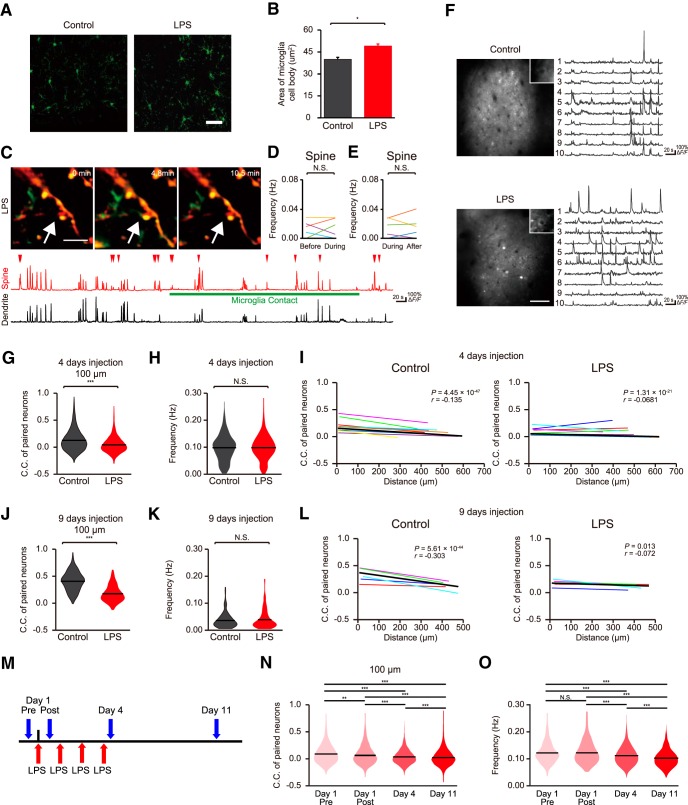
Microglia-synapse interactions in mice following LPS injections. A, B, Intraperitoneal injection of LPS activated microglia, as verified by morphologic appearance (A), which included a significant increase in soma diameter (B). Soma area increased from 40.1 ± 9.2 μm2 in saline-injected mice (n = 58 cells from three mice) to 49.2 ± 11 μm2 in LPS-injected mice (n = 80 cells from three mice, p = 4.30 × 10−7, unpaired t test). C, top, Fluorescent image of a dendrite in L2/3 of the primary motor cortex of an LPS-injected mice showing the simultaneous imaging of spines (tdTomato; red) and microglia (EGFP; green). Scale bar: 5 μm. As in Figure 1, the lower trace shows a sample recording of Ca2+ transients (GCaMP6f fluorescence ΔF/F) in a single spine (upper) and in the parent dendrite (lower) before, during, and after microglial contact. Local synaptic activity was not effected by microglial contact. The white arrow indicate the spine contacted by microglia process. D, E, The frequency of Ca2+ transients in spines during the period of microglial contact was not significantly different from that either before (D) or after (E) contact. Each line shows data from a single experiment [D: 0.013 ± 0.003 Hz (during) vs 0.012 ± 0.003 Hz (before), p = 0.816, n = 6 fields from three mice; E: 0.013 ± 0.004 Hz (during) vs 0.014 ± 0.005 Hz (after), p = 0.843, n = 6 fields from three mice, paired t test]. F, Typical fields of view of neurons with GCaMP6f fluorescence in L2/3 of the primary motor cortex of saline-injected mice (upper) and LPS-injected mice (lower), with accompanying representative ΔF/F Ca2+ traces from ten individual neurons in each mouse. G–L, Distribution of C.C.s (G, J) and of neuronal firing frequencies (H, K) in mice injected with either saline or LPS for 4 d (G, H) or 9 d (J, K). LPS injections decreased the C.C. for pairs of closely located neurons but had no effect on neuronal firing frequencies. Panels I, L show the relationship between C.C. and neuronal separation for mice injected with either saline or LPS for 4 d (I) or 9 d (L). Each line shows the slope of the correlation from individual mice, while the values in the top right corner show the slope of the fits to the complete data set (and the value of the Pearson’s correlation test), the fit to this grouped data are shown as the solid dark line. Averaging the individual fits gives a mean slope correlation of: r = –0.149 ± 0.019 for 4 d saline mice (p = 5.43 × 10−5, one-sample t test, n = 9 mice), r = –0.008 ± 0.039 for 4 d LPS mice (p = 0.850, n = 9 mice), r = –0.285 ± 0.065, for 9 d saline (p = 0.012, n = 5 mice), and r = –0.107 ± 0.048 for 9 d LPS [p = 0.091, n = 5 mice; G: saline-injected mice (4 d injection, n = 9 mice); 0.12 ± 0.004, LPS-injected mice (4 d injection, n = 9 mice); 0.043 ± 0.002, p = 7.02 × 10−72, Wilcoxon rank sum test; H: control (4 d injection, n = 464 neurons from nine mice); 0.098 ± 0.002 Hz, LPS (4 d injection, n = 568 neurons from nine mice); 0.098 ± 0.002 Hz, p = 0.841, Wilcoxon rank sum test; I; control (4 d injection); r = –0.135, p = 4.45 × 10−47, LPS (4 d injection); r = –0.0681, p = 1.31 × 10−21, Pearson’s correlation test; J; saline-injected mice (9 d injection, n = 5 mice); 0.34 ± 0.008, LPS-injected mice (9 d injection, n = 5 mice); 0.18 ± 0.009, p = 3.61 × 10−30, Wilcoxon rank sum test; K; saline-injected mice (9 d injection, n = 141 neurons from five mice); 0.033 ± 0.002 Hz, LPS-injected mice (9 d injection, n = 108 neurons from five mice); 0.037 ± 0.003 Hz, p = 0.60, Wilcoxon rank sum test; L; control (9 d injection); r = –0.303, p = 5.61 × 10−44, LPS (9 d injection); r = –0.072, p = 0.013, Pearson’s correlation test]. Hence LPS injection abolished the correlation between C.C. and neuronal separation. M–O, In an additional cohort of mice, L2/3 neurons were imaged before LPS< and again 1 and 4 d after daily LPS injections, and then after 7 d of recovery from the last LPS injection (M). The distributions of the C.C. (N) and the neuronal firing frequencies (O) over these time periods are shown. LPS injection caused a significant decrease in C.C., which was evident by the first day of injection and did not recover following a week after the last LPS injection. (N). From 4 d after LPS, the firing frequency in this mouse cohort decreased, and there was a further decrease by one week after the last LPS injection [O; N: F(3,19984) = 189.29, p = 0.002 (day 1 pre; 0.089 ± 0.004 vs day 1 post; 0.074 ± 0.003), p = 3.77 × 10−9 (day 1 pre; 0.089 ± 0.004 vs day 4; 0.035 ± 0.002), p = 3.77 × 10−9 (day 1 pre; 0.089 ± 0.004 vs day 11; 0.023 ± 0.001), p = 3.77 × 10−9 (day 1 post; 0.074 ± 0.003 vs day 4; 0.035 ± 0.002), p = 3.77 × 10−9 (day 1 post; 0.074 ± 0.003 vs day 11; 0.023 ± 0.001), p = 1.93 × 10−9 (day 4; 0.035 ± 0.002 vs day 11; 0.023 ± 0.001), one-way ANOVA followed by Tukey’s test; O: day 1 pre (n = 320 neurons, seven fields from four mice); 0.122 ± 0.002 Hz, day 1 post (n = 325 neurons, seven fields from four mice); 0.122 ± 0.002 Hz, day 4 (n = 449 neurons, seven fields from four mice); 0.112 ± 0.002 Hz, day 11 (n = 737 neurons, seven fields from four mice); 0.102 ± 0.001 Hz, F(3,1827) = 37.13, p = 1.00 (day 1 pre vs day 1 post), p = 2.43 × 10−4 (day 1 pre vs day 4), p = 3.77 × 10−9 (day 1 pre vs day 11), p = 1.54 × 10−4 (day 1 post vs day 4), p = 3.77 × 10−9 (day 1 post vs day 11), p = 5.09 × 10−5 (day 4 post vs day 11), one-way ANOVA followed by Tukey’s test]. Data in B shows the mean ± SEM, the dark lines in panels G, H, J, K, N, O represent the means; *p < 0.05, **p < 0.01, ***p < 0.001, n.s.: non-significant.